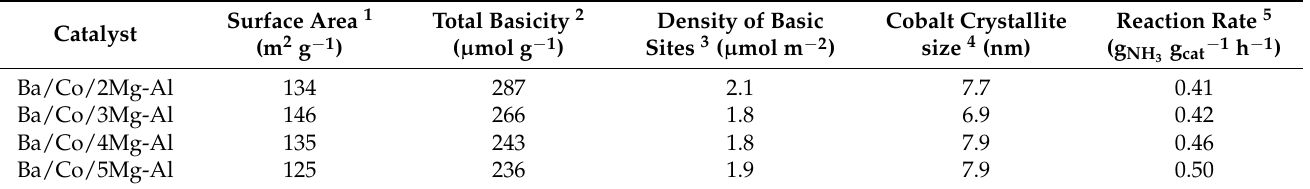
Table 3. Physicochemical properties and catalytic activity in the ammonia synthesis reaction of the barium-promoted cobalt catalysts supported on Mg-Al mixed oxides